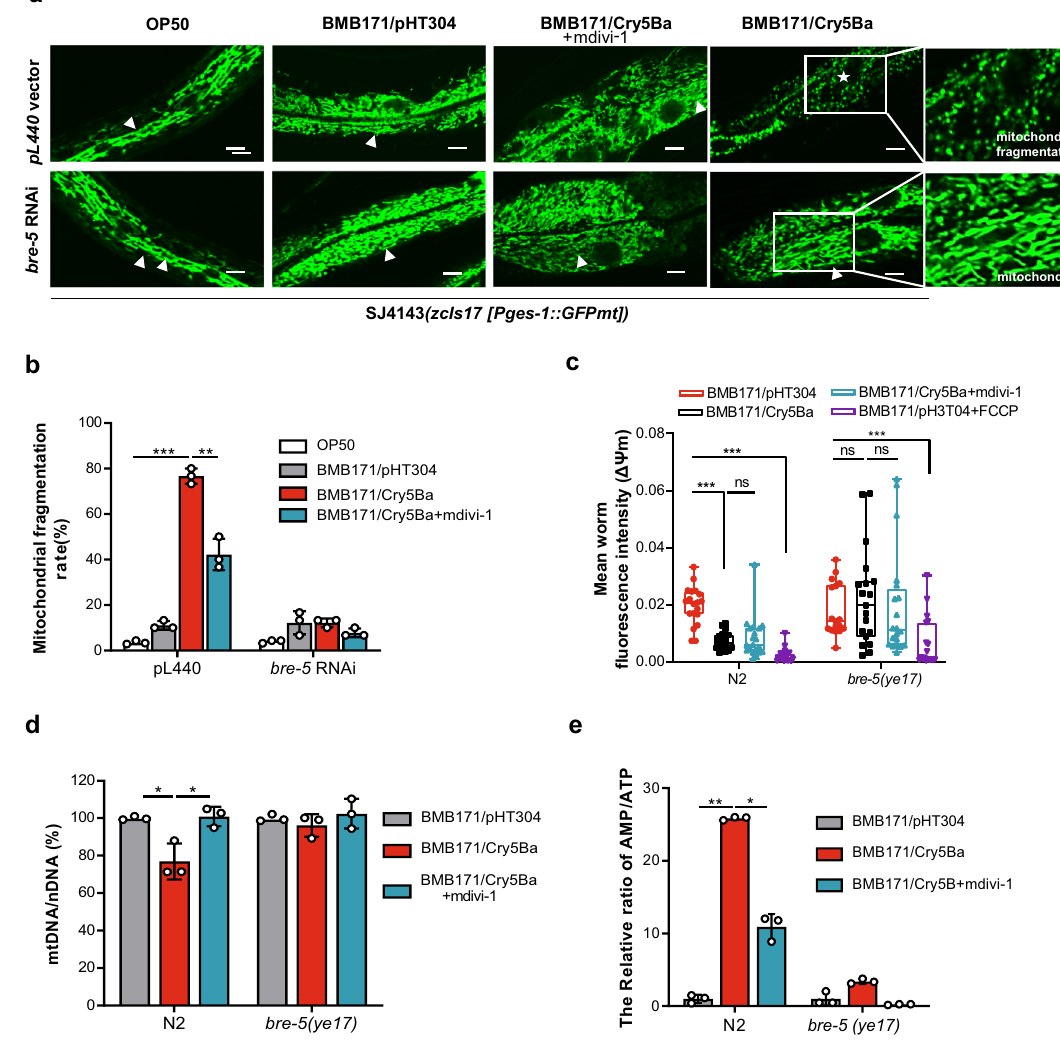
Fig. 2 Bt infection leads to mitochondria damage. a Observations of the mitochondrial morphology of transgenic C. elegans SJ4143(zcIs17 [P ges-1 ::GFP mt ]) fed without or with bre-5 RNAi. The images depicted are representative images of worms treated by each strain (triangle: mitochondria in the fusion state, showing tubular shape; star: mitochondria in the split state, showing punctate shape which represents mitochondria fragmentation (MF). The scan bars represent 20 μ m. N = 3 independent experiments. b Transgenic worms were treated with each Bt strain after being subjected to bre-5 RNAi (resistant to toxin exposure) or empty vector. Count the percentage of worms with the mitochondria fragmentation phenotype after treatment in each condition. N = 3 independent experiments containing at least 50 worms each. c Analysis of the mitochondrial membrane potential ( ΔΨ m) by fl uorescent dye stetramethyl rhodamine ethyl ester under each treatment for 4 h. The level of ΔΨ m was determined by the fl uorescence intensity of each worm. N = 3 independent experiments containing at least 20 worms. d The relative ratio of mtDNA /nDNA was investigated by real-time PCR. N = 3 independent experiments. e The relative AMP/ATP ratio was measured in each condition. In each experiment, worms were treated for 4 h. N = 3 independent experiments. FCCP: a protonophore can decrease mitochondrial membrane potential; mdivi-1: an ef fi cient inhibitor that attenuates mitochondrial division. Data points represent the mean values of three independent replicates, error bars denote the SD in ( b ), ( d ), and ( e ). The whiskers represent the data range (minimum – maximum), and the box shows the 75th percentile, 25th percentile, and median in ( c ). The p -value was determined by a Student ’ s t -test (Welch ’ s correction for unequal variances), *** p < 0.001, ** p < 0.01, * p < decrease in potassium ion, but not calcium ion, concentration whether Cry5Ba can directly target mitochondrial. By feeding (Fig. 3b and Supplementary Fig. 6). In a K + -free environment, the SJ4143 worms with rhodamine-labeled Cry5Ba and using the leakage of potassium is more serious. When the potassium con- endocytosis-labeled worm RT311[P vha-6 ::GFP::RAB-11] as a control, our results showed Cry5Ba is translocated into epithelial centration increased, the leakage of potassium could be alleviated. cells as shown by white spots, but does not colocalize with Conversely in bre-5 ( ye17 ) worms, potassium content did not mitochondria (Fig. 3a). In addition to targeting mitochondria change at any condition (Fig. 3b and Supplementary Fig. 5). Thus directly, it had been proved PFTs can lead to severe ion dysre- we can conclude that during the Bt infection, Cry5Ba caused gulation, which has been demonstrated to be important for intracellular potassium leakage. mitochondria 44,45 . So we assessed the cellular Ca 2 + and K + levels To verify our hypothesis that potassium leakage is the direct after Bt infection. We found that Bt infection caused a signi fi cant reason for mitochondrial damage. We detected the MF